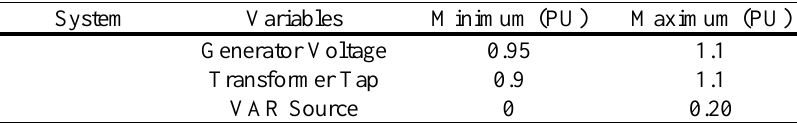
Table 7. Constraints of control